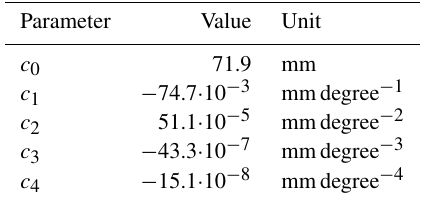
Table 3. Values for the parameters of the intermission difference